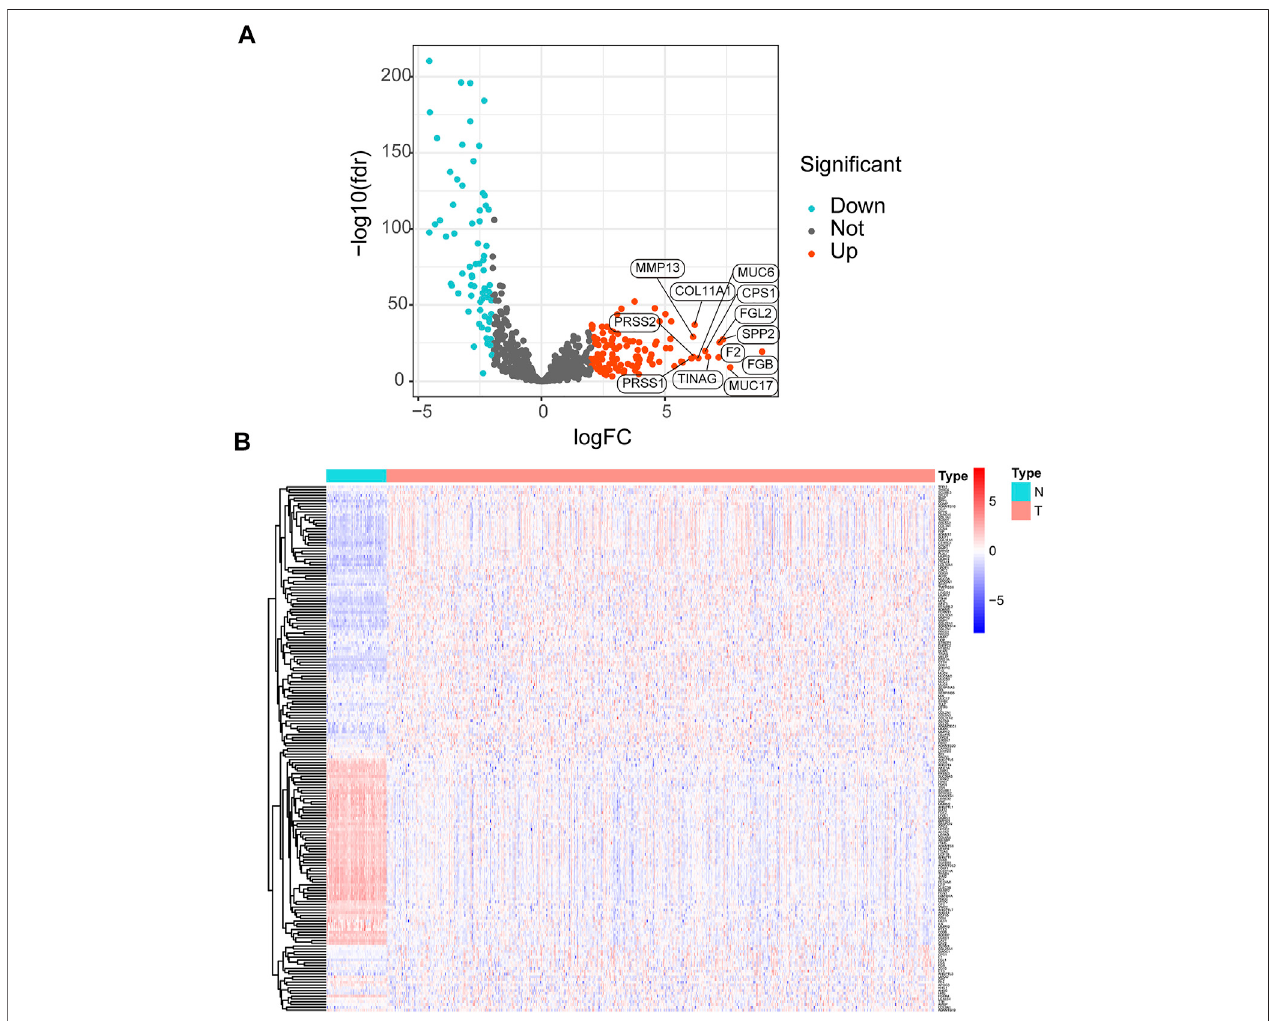
FIGURE2| AnalysisofdifferentiallyexpressedERGs (A) VolcanoplotofdifferentiallyexpressedERGs,showingtheFDRandlog2-foldchangeofeachgene (B) The heatmap shows the distribution of 189 differentially expressed ERGs between LUAD and normal lung tissues. ERGs = extracellular matrix-related genes; FDR = false discovery rate; LUAD = lung